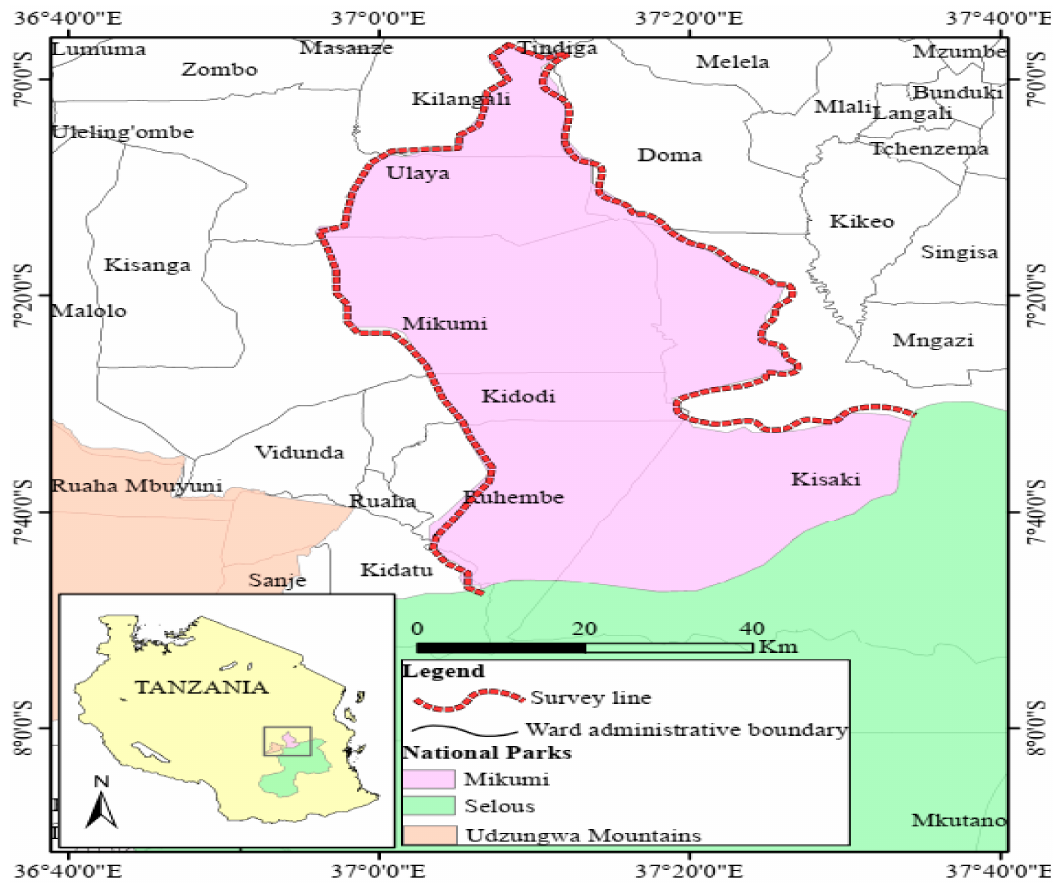
Figure 1. Map showing wildlife-livestock interface ecosystem of Mikumi National Park. Data source; (National Bureau of Statistics (Geograhic Information System) data base; https://www.nbs.go.tz/index.php/en/) (accessed on 18 November